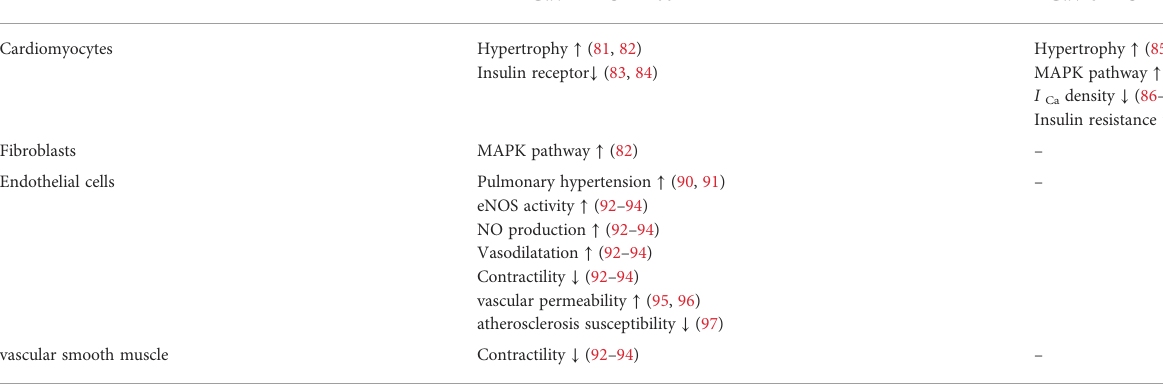
TABLE 1 Summary of pathological fi ndings in Cav-1/Cav-3 KO